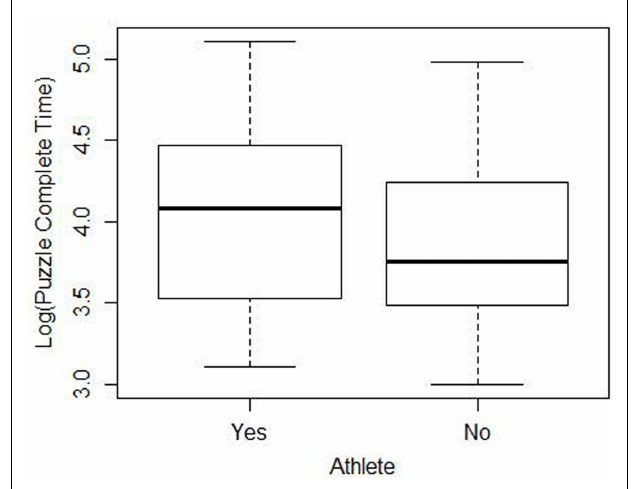
FIGURE 3 | Side-by-side boxplots of the log of completion time for the cleaned